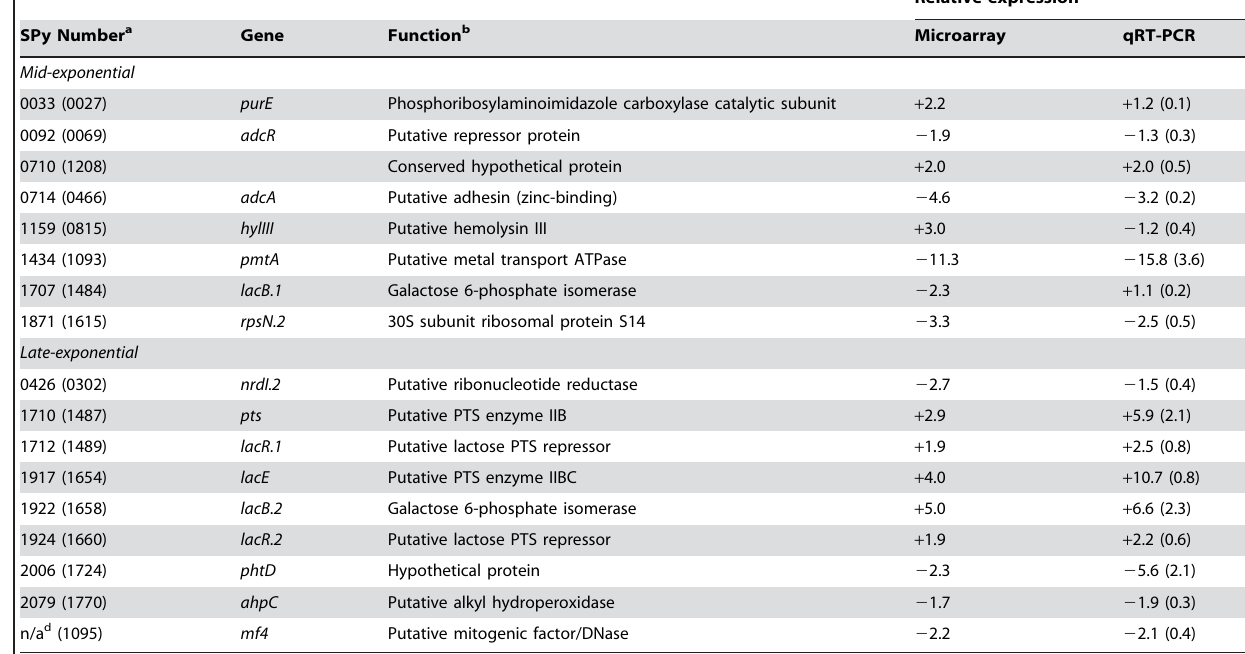
Relative expression